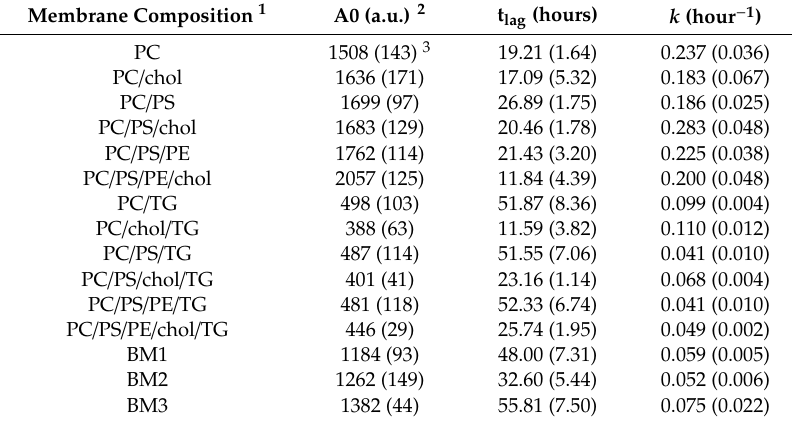
Table 2. Summary of the best-fit parameters for ThT